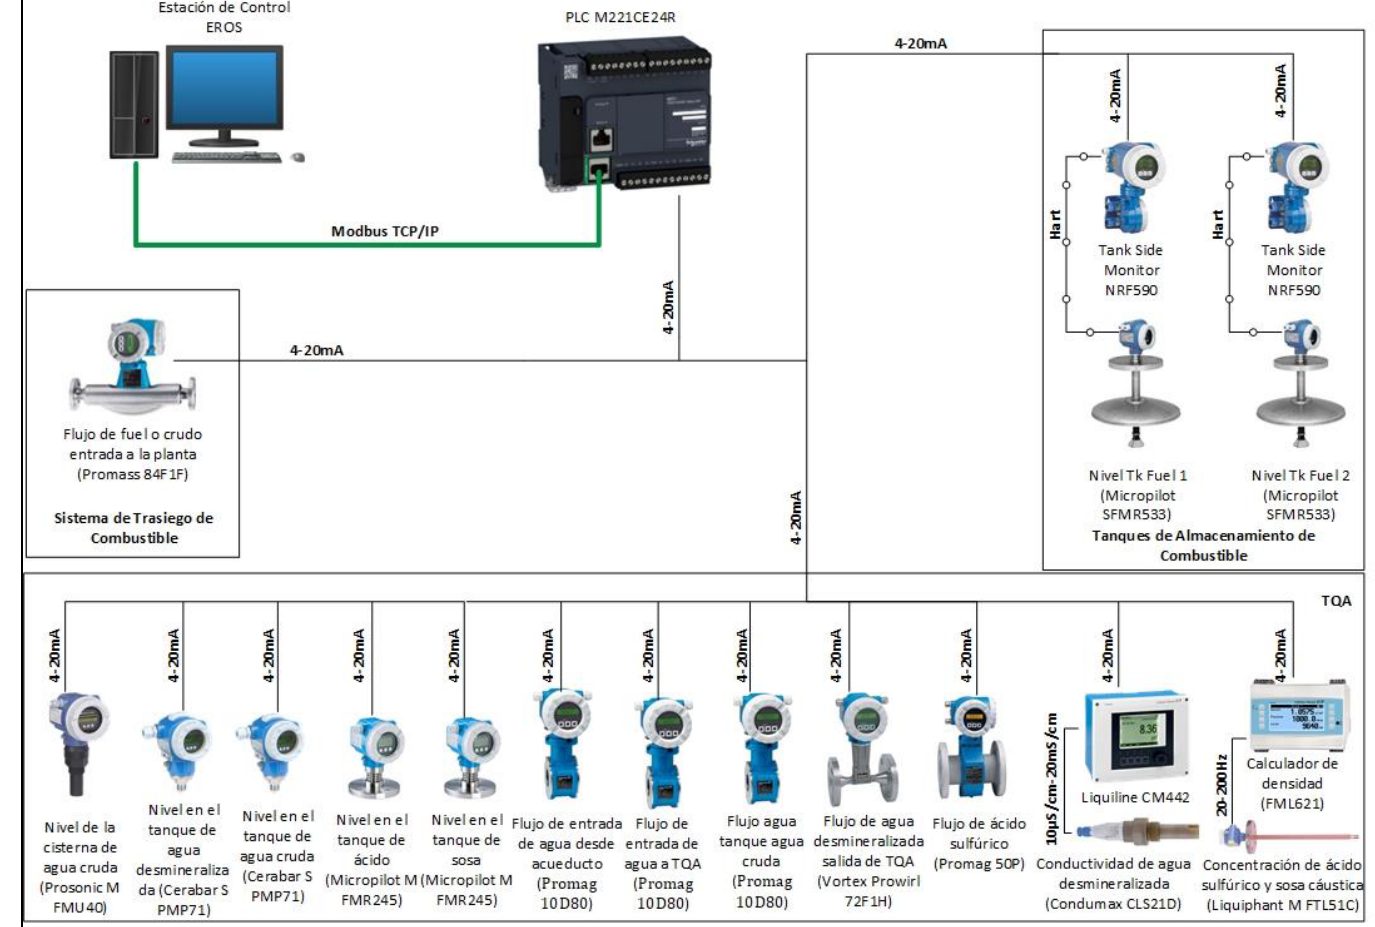
Figure 1: SCADA system